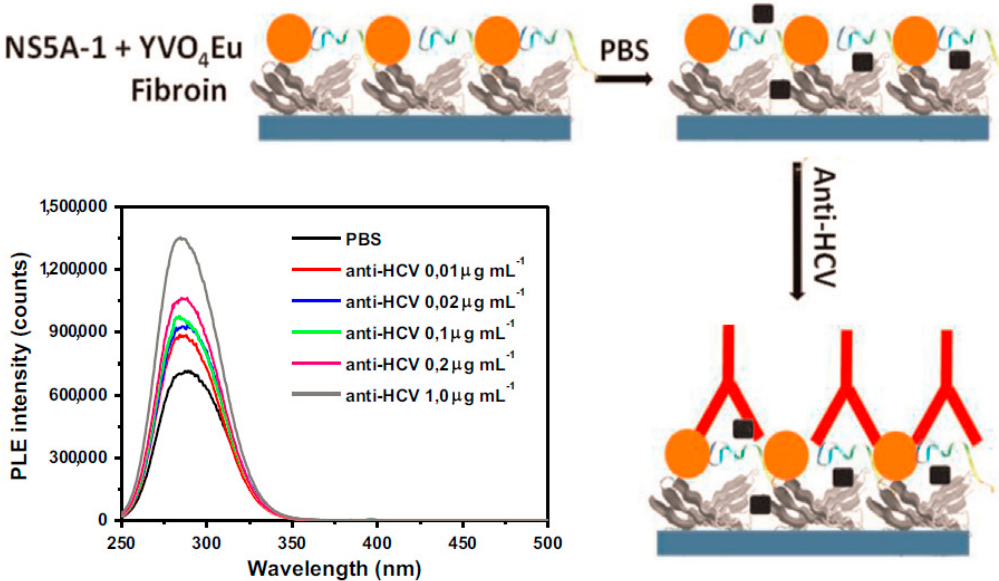
Figure 5. Schematic representation and PL spectra of the as-prepared biosensor. The LbL film of SF/NS5A-1+YVO 4 :Eu 3+ NPs showed specific recognition in the presence of anti-HCV antibodies. PL spectra obtained for the LbL film containing five bilayers of fibroin/NS5A-1+YVO 4 :Eu 3 NPs in the presence of different concentrations of anti-HCV. Reproduced from [33] with permission from Elsevier.